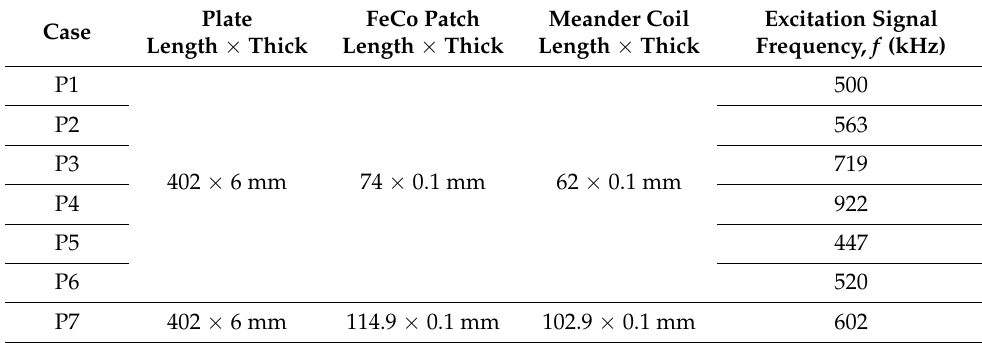
Table 1. Component geometry and excitation signal frequency for different modeling